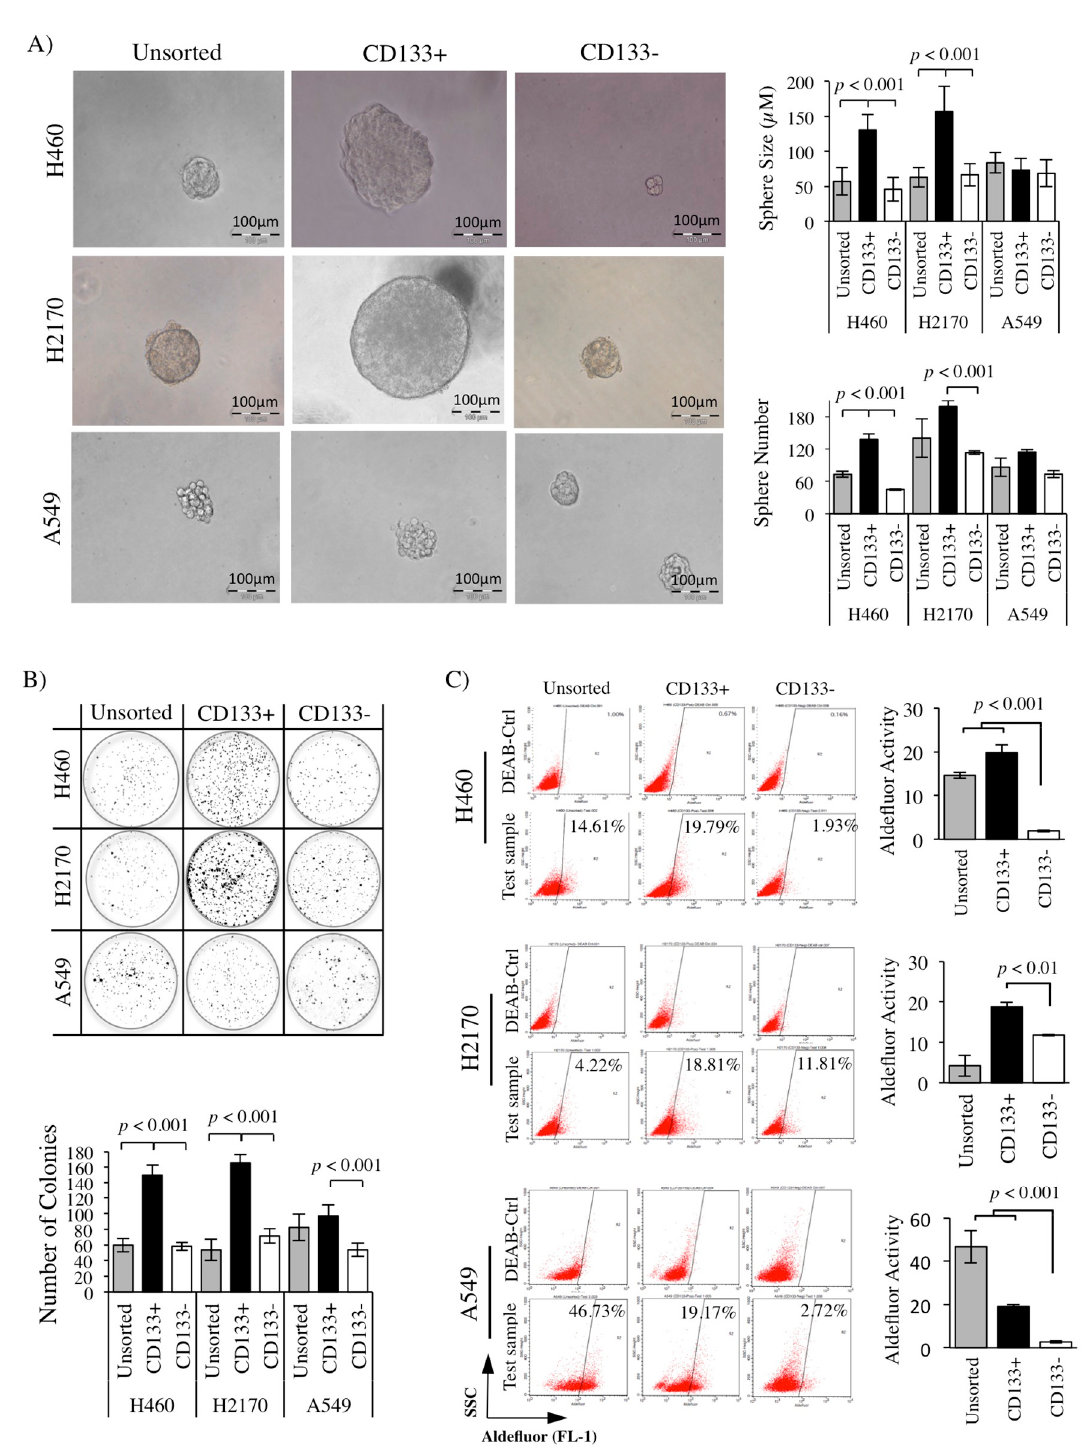
Figure 4. Isolated CD133 + populations exhibit the characteristics of CSCs. ( A ) Sphere formation of CD133 + population derived from NSCLC cell lines in anchorage-independent culture. Substantially bigger and a higher number of spheres in the CD133 + CSCs as compared to control (CD133 − and unsorted) in both H460 and H2170 cell lines. ( B ) A significant number of colonies was noted in the CD133 + CSCs as compared to CD133 − (non-CSCs) population in all of the NSCLC cell lines. ( C ) Aldefluor assay indicating high ALDH activity in the CD133 + NSCLC-derived CSCs ( p < 0.001; t -test).